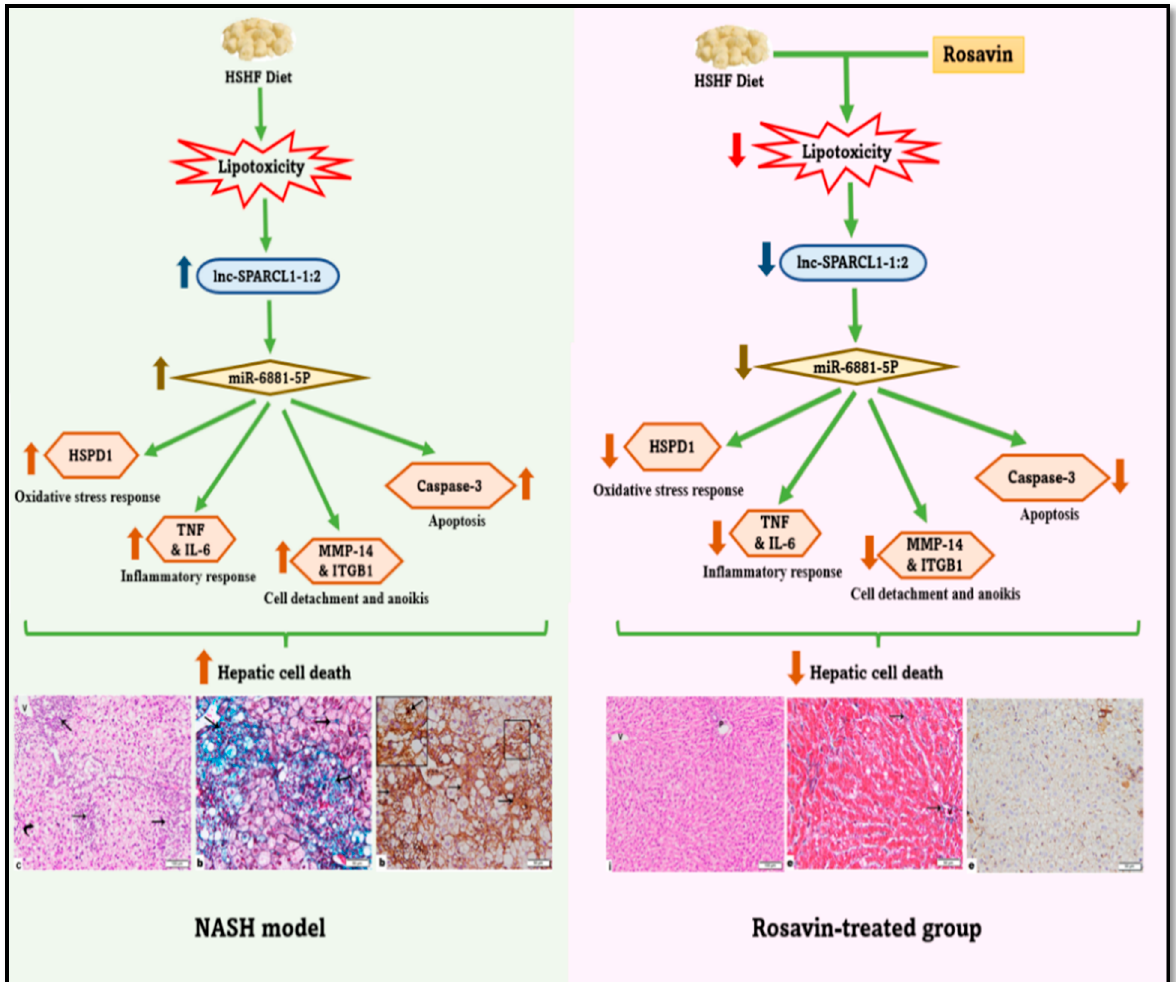
Figure 6. Schematic presentation of the study hypothesis.